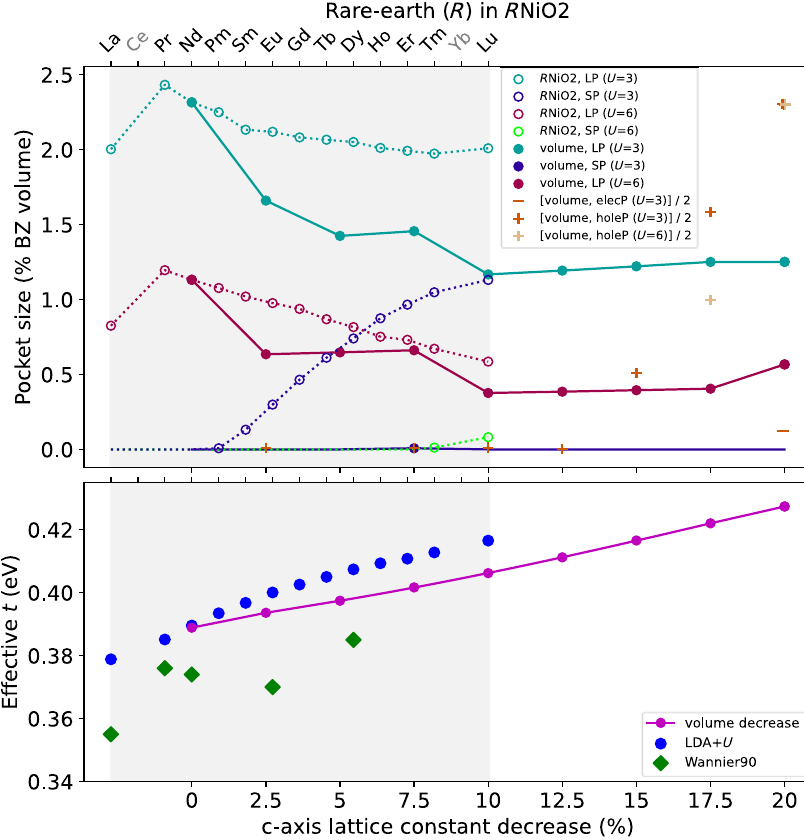
FIG. 8. Comparison between volume change with static R ¼ Nd and when rare-earth R changes in R NiO 2 . Top panel: effects on electron pockets for the two scenarios. LP and SP represent the large pocket and small pocket for the R 5d orbital, labeled with circles. When only the volume changes and rare earth stays constant, the second electron pocket (small pocket labeled SP) never substantially appears, and hole pockets start appearing in various parts of the BZ (namely, along Y − X and some along Γ − Σ ). These anomalous hole pockets (and one electron pocket at 20%) that appear along the BZ edge are shown at 0.5 times their actual values. Bottom panel: hopping t estimated by 1 × ð Ni 3 d x 2 − y 2 bandwidth Þ from the noninteracting DFT calculations. Changes in t from exchanging rare-earth R 8 are significantly greater than those from a simple volume change.